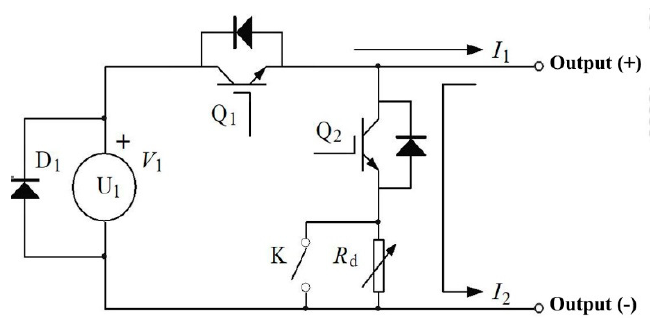
Figure 2. The simplified topology of the power supply Mode with Discharge Loop Current.